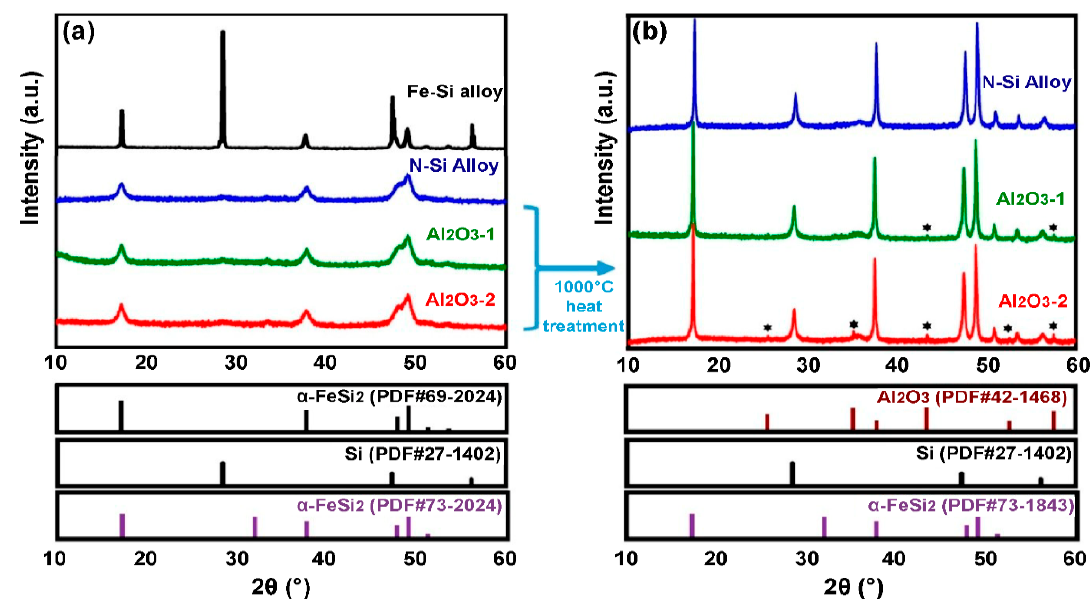
Figure 4. XRD patterns of the N-Si alloy, Al 2 O 3 -1, and Al 2 O 3 -2 powders: ( a ) Before heat treatment and ( b ) after heat treatment at 1000 °C. * new Peak was created (Al2O3-1,2,